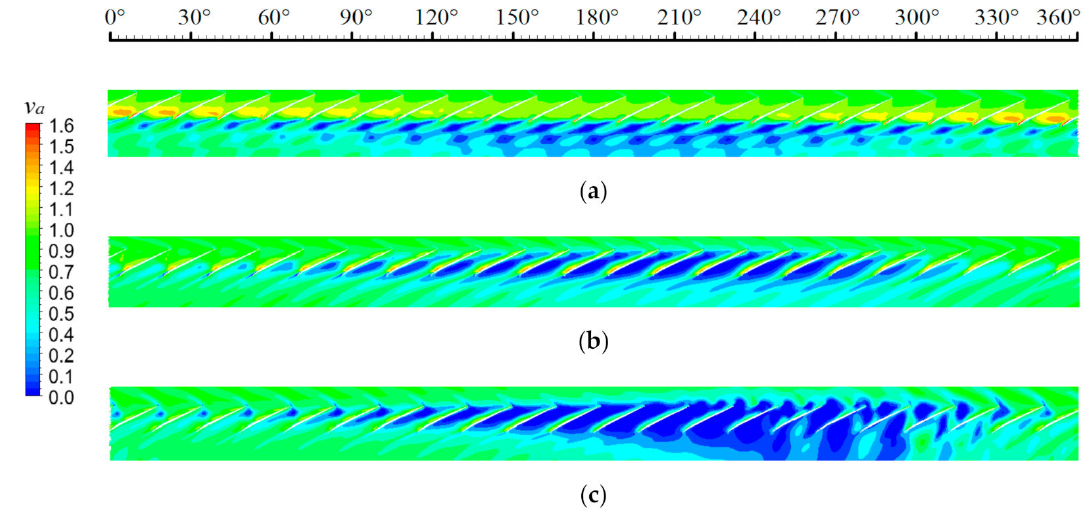
Figure 20. The circumferential distribution of the blade tip axial velocity coe ffi cient calculated by unsteady CFD under di ff erent working conditions at E = 160%. ( a ) NC; ( b ) NPE; ( c )